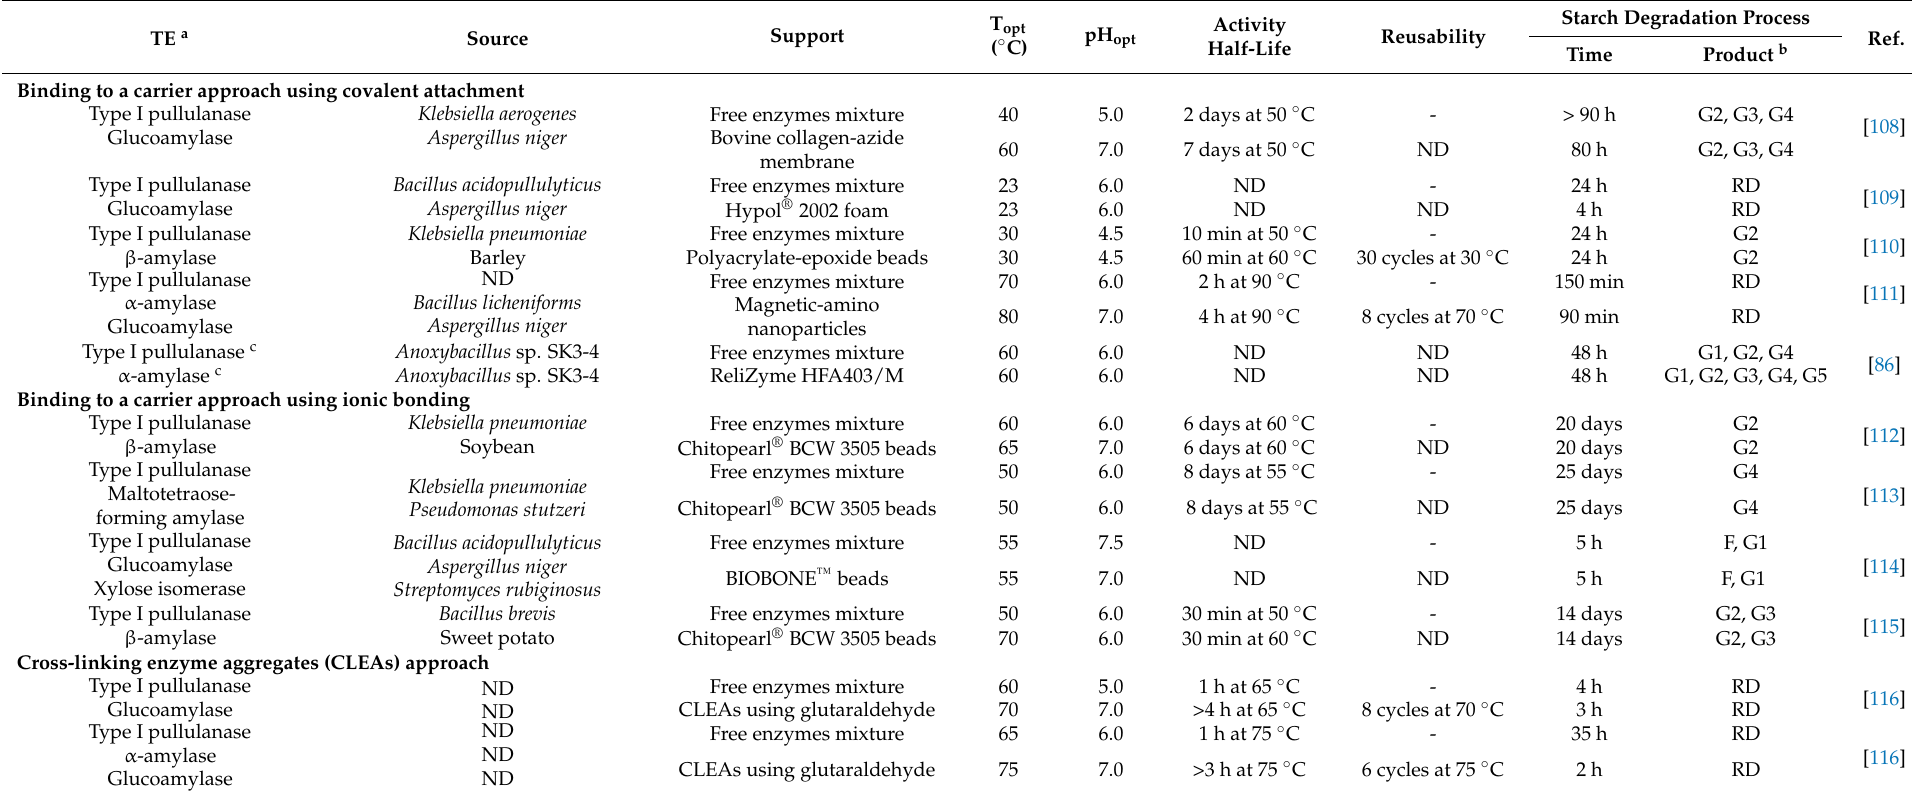
Table 6. List of co-immobilisations of pullulan-degrading enzymes with various glycoside